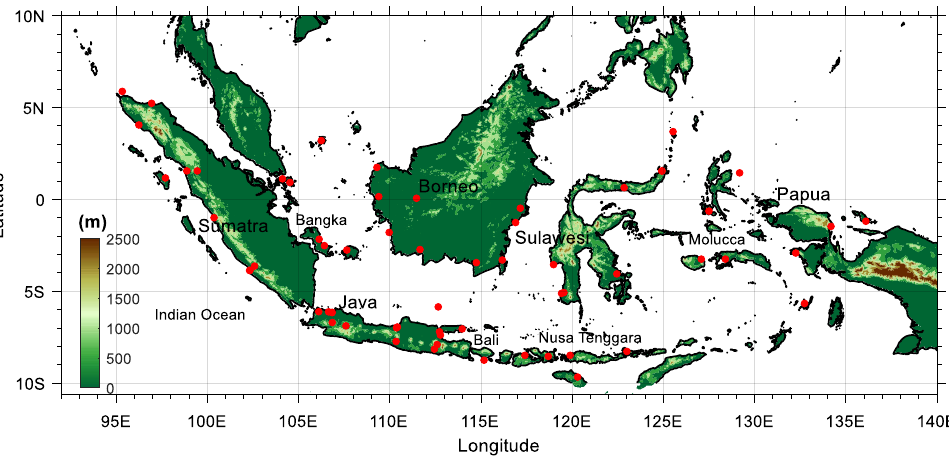
Figure 1. Distribution of BMKG stations used in this study. Elevation data were gridded in 15-arc second by General Bathymetric Chart of the Oceans (GEBCO) [64].